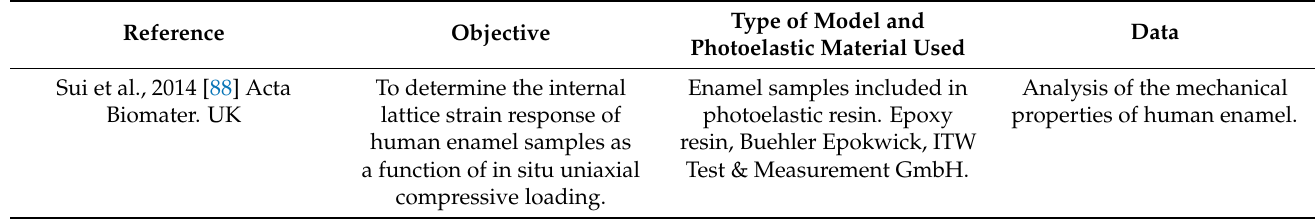
Table 10. Characteristics and findings of studies on basic science in the dental